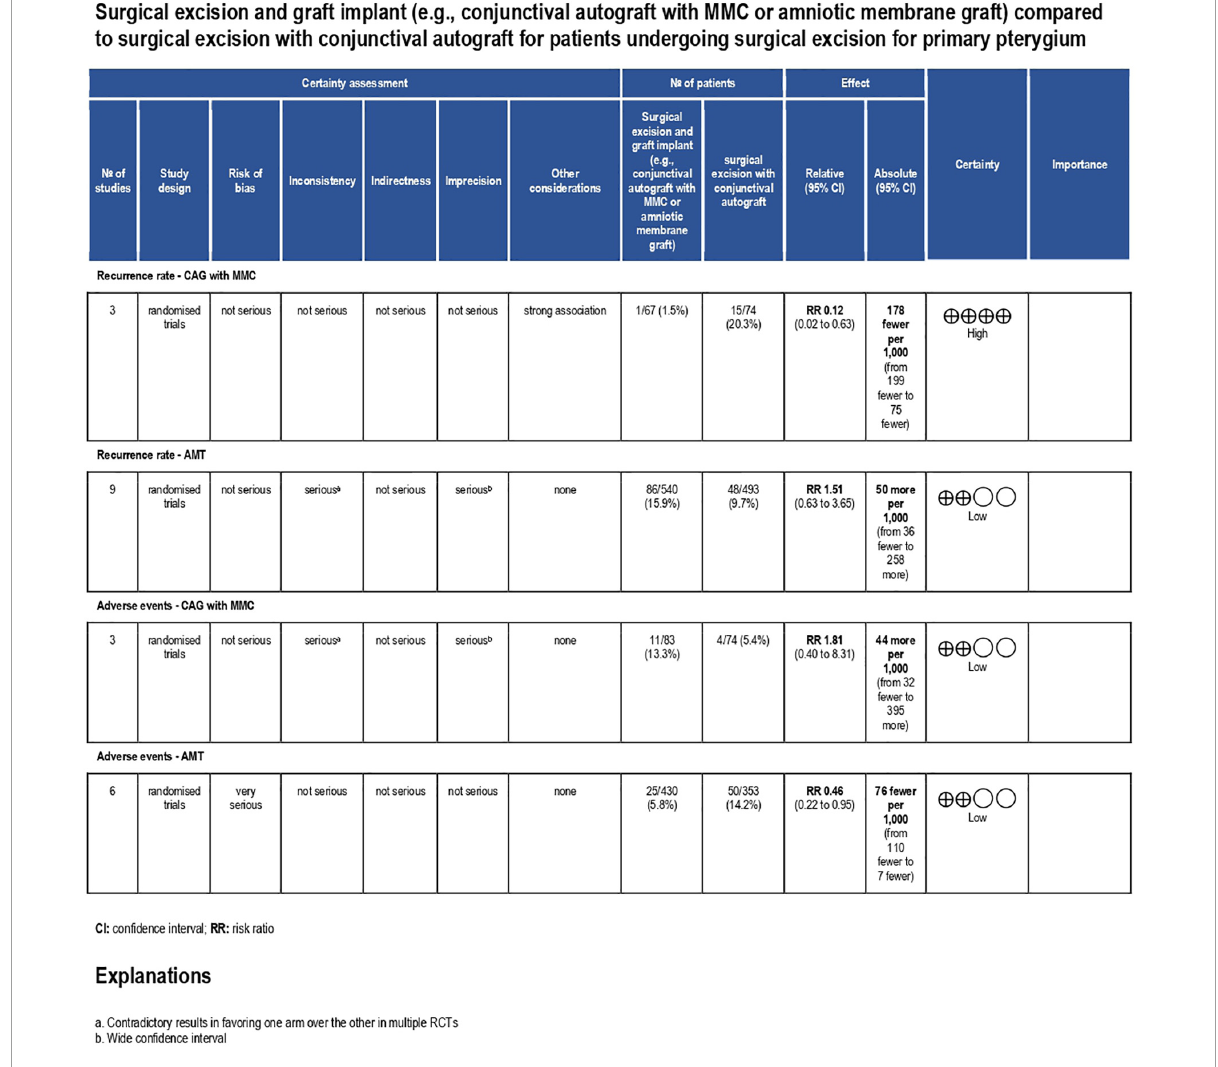
FIGURE4 Grading of recommendations assessment, development and evaluation (GRADE) evidence profile. CI, confidence interval; RCT, randomized controlled trial; ROP, retinopathy of prematurity; RR, risk ratio; CAG, conjunctival autograft; AMT, amniotic membrane transplantation; MMC, mitomycin